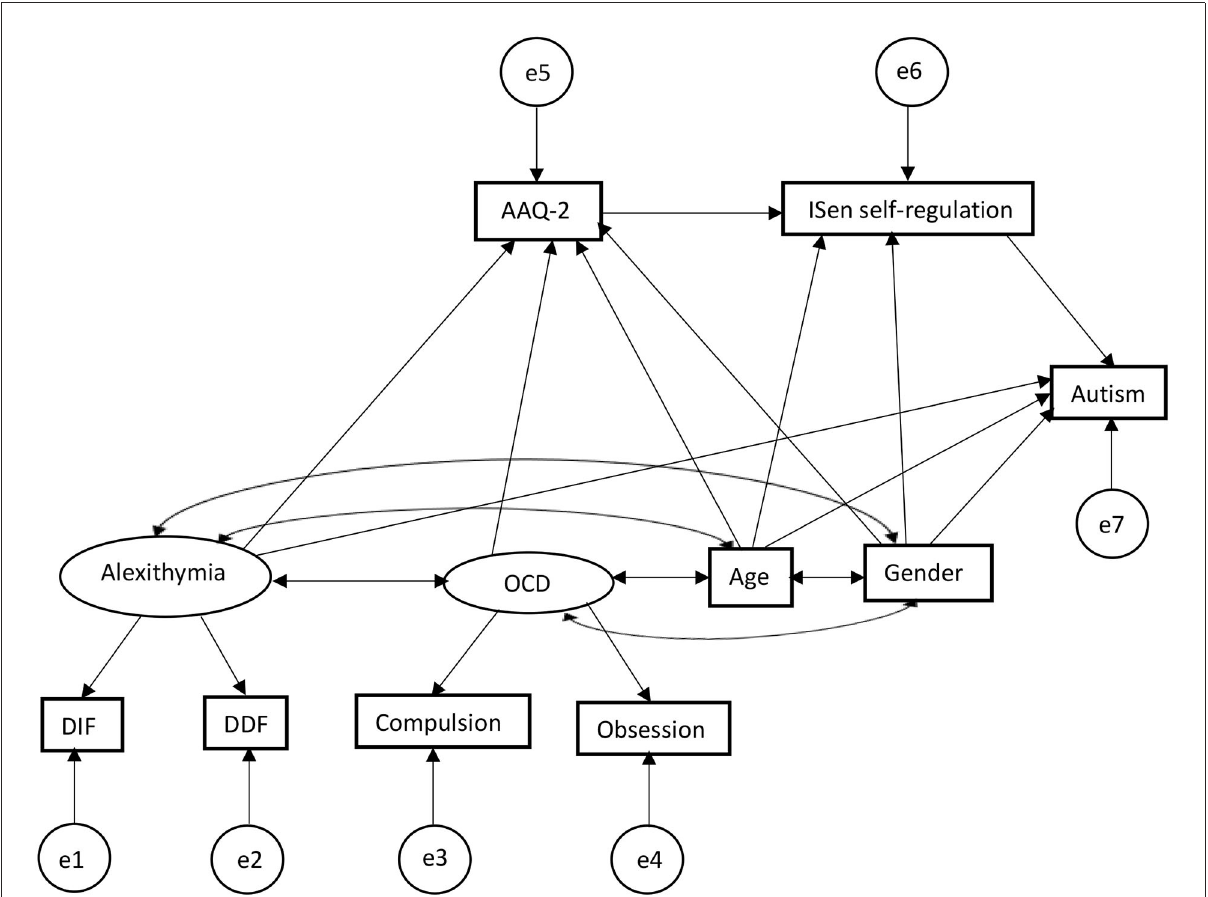
FIGURE2 SEM first output predictors for autism, showing alexithymia and OCD are related indirectly (alexithymia via serial mediation) through psychological inflexibility and ISen self-regulation in predictively causing